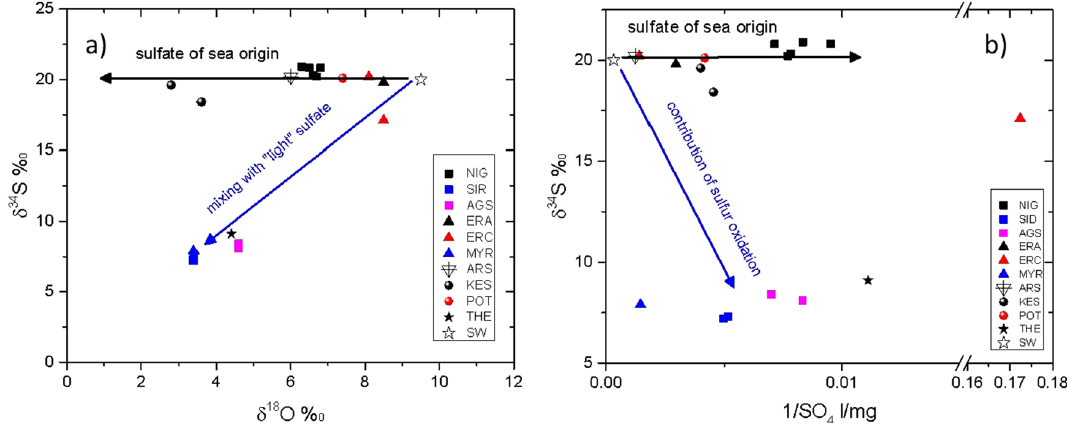
Figure 7. ( a ) δ 18 O versus δ 34 S, values of the thermal waters for all studied areas. ( b ) 1/SO 4 versus δ 34 S of the thermal waters for all studied